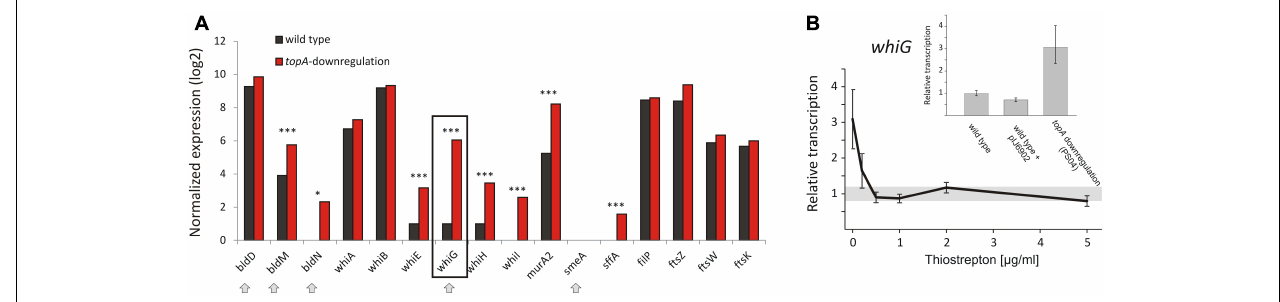
FIGURE 5 | Topoisomerase I depletion-induced changes in the transcription of genes involved in sporulation regulatory cascades. (A) RNA-Seq based expression of selected genes encoding for whi and bld regulatory cascades genes normalized by the upper quartile in the wild type strain (black) and the TopA-depleted strain (red). The genes belonging to the BldD regulon are marked with arrows. The statistically significant changes in transcript levels were marked with asterisks ( ∗ p -value < 0.05; ∗∗∗ p -value < 0.001). p -Values were calculated based on RNA-Seq data analysis for four independent biological replicates for the wild type and topA -downregulated strains. (B) RT-qPCR analysis of whiG transcript levels at different concentrations of the topA gene inducer. Wild type levels of whiG transcription were set at 1, and standard deviation for wild type transcription is marked with a gray bar. The inset shows RT-qPCR analysis of whiG transcript levels in the TopA-depleted and the wild type strains, as well as the control strain that contained the pIJ6902 plasmid without the topA gene. The whiG transcript enrichment was normalized by the expression of the hrdB gene which served as the endogenous control and compared to the wild type strain in which transcription was estimated as